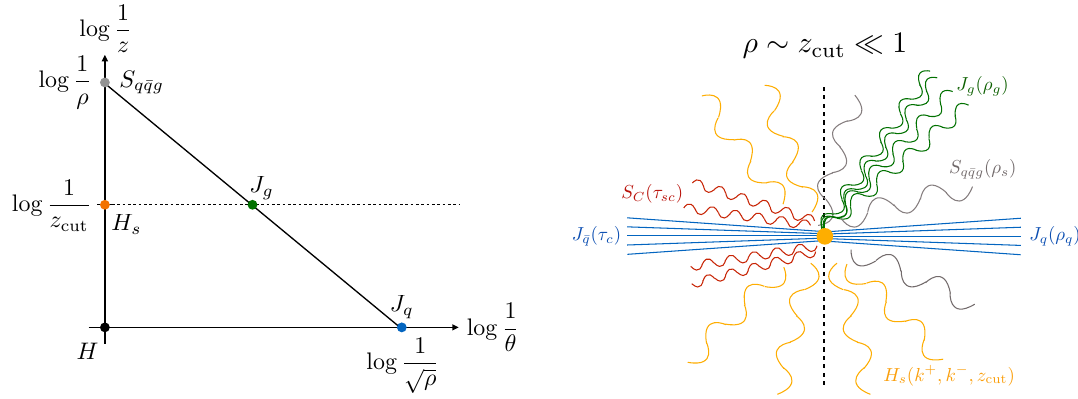
Figure 1 . Schematic illustration of factorization theorem for the cusp region of the groomer. Left: the structure of the factorization theorem for the right hemisphere of the event on the Lund plane, corresponding to the hemisphere with the resolved emission that passes the groomer. Right: a physical representation of the event with the modes in the factorization theorem